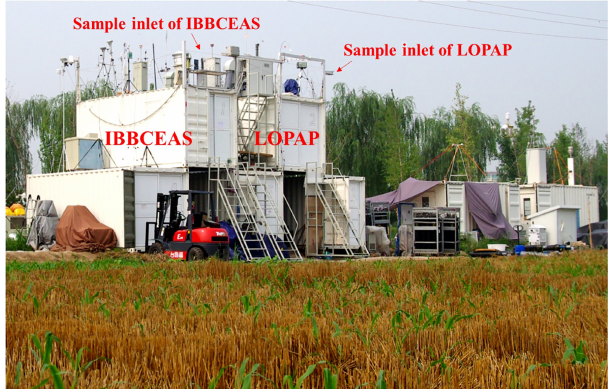
Figure 9. The measurement site of CAREBEIJING and the con- tainer in which the IBBCEAS instrument was placed.